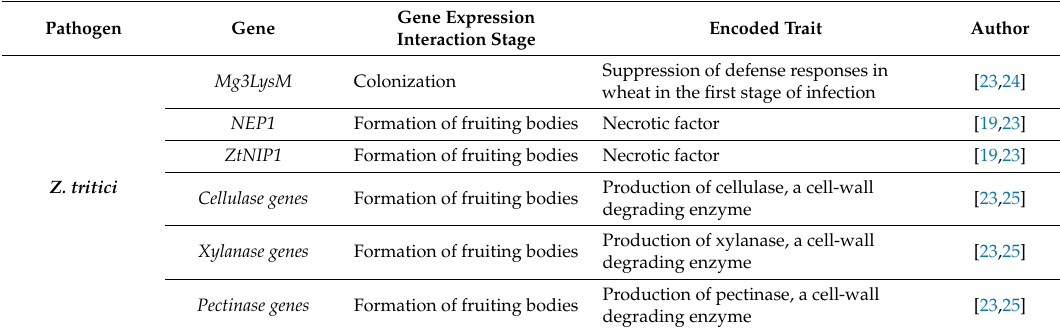
Table 1. Major genes controlling the infection cycle of Z. tritici , F. graminearum and P. nodorum .